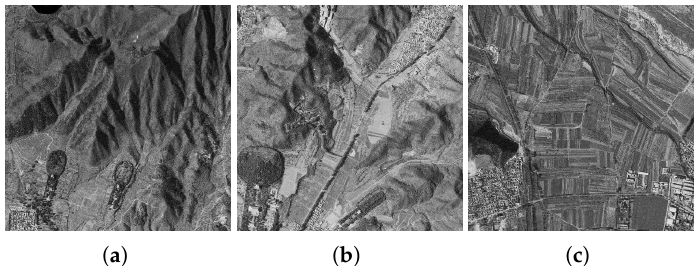
Figure 10. Three real-life noisy RSI images used for further testing. ( a ) Mountain . ( b ) City-wall . ( c ) Factory .